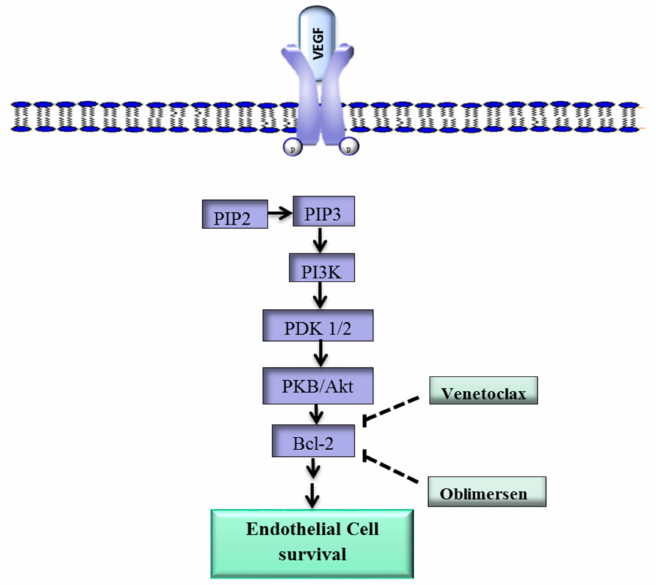
Figure 1. Overview of the VEGF-Bcl-2-mediated cell survival pathway. The VEGF ligand binds to VEGFR-2 and activates PI3K/Akt, which leads to the upregulation of Bcl-2 and ultimately promotes cell survival. The drugs Venetoclax and oblimersen inhibit Bcl-2. VEGF, vegfr-2, vascular endothelial growth factor; VEGFR-2, vascular endothelial growth factor-2; Bcl-2, B-cell lymphoma 2; PKB, protein kinase B; PDK1/2, protein 3-phosphoinositide-dependent protein kinase-1 and -2; PIP2, phosphatidylinositol 4,5-bisphosphate; PIP3, phosphatidylinositol 3,4,5-trisphosphate; inhibit; → ,